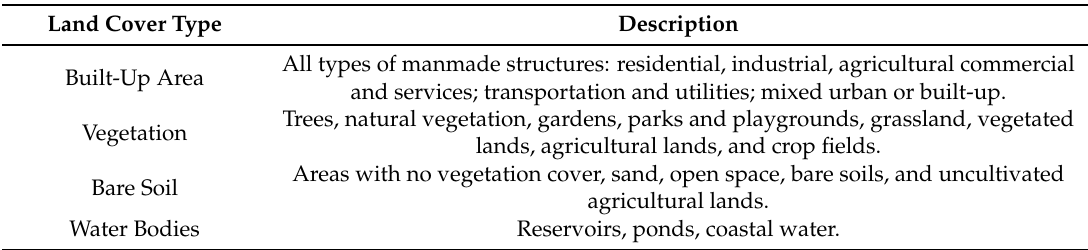
Table 2. Land cover classification scheme used in the